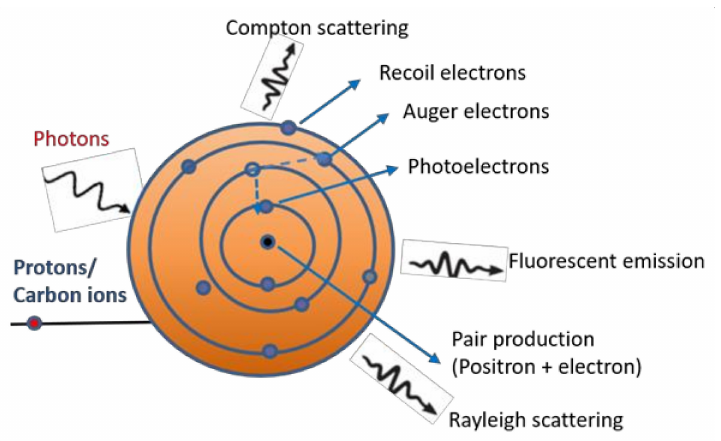
Figure 1. Interaction of X-rays, protons, and carbon ions with high-Z